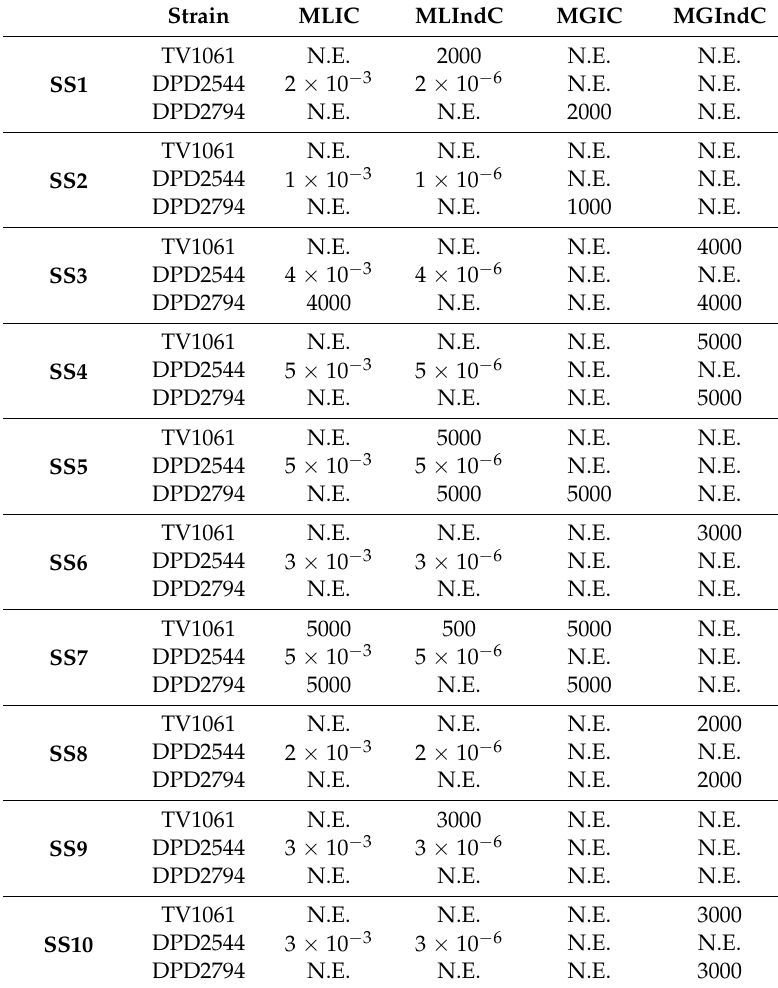
Table 2. Sport supplements’ toxicity and viability effect ( µ g/mL).